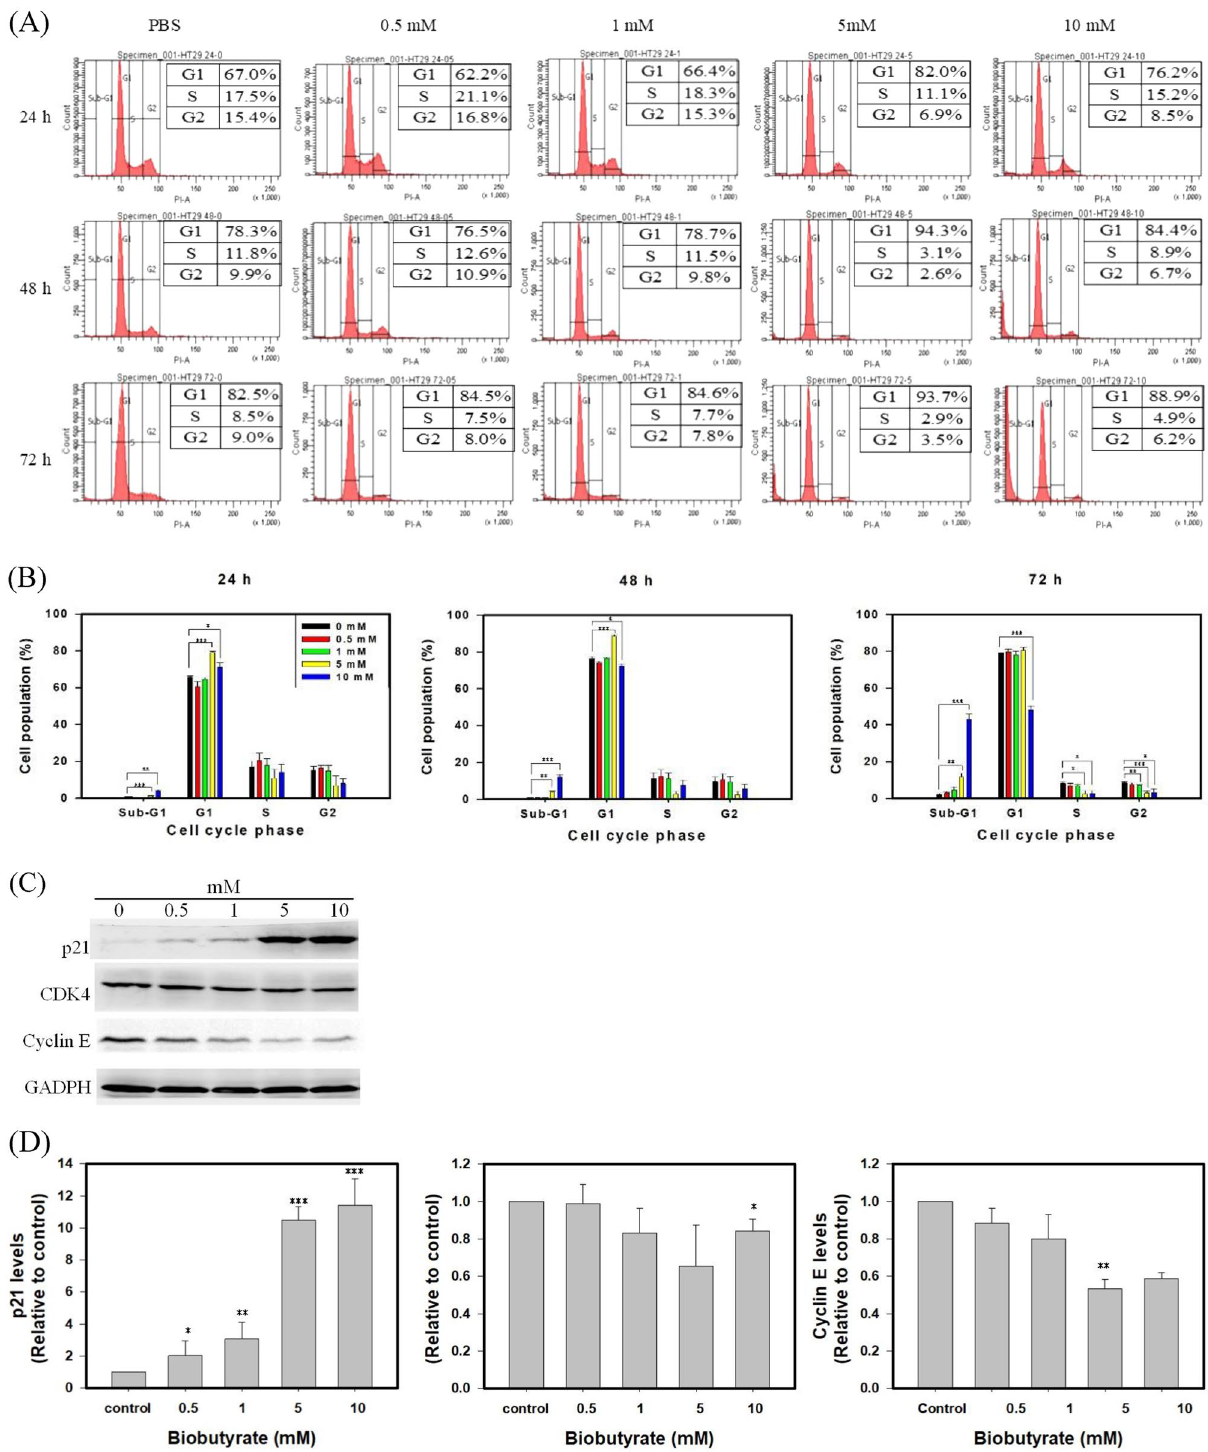
Figure 3. Cell cycle analysis. Cancer cells were treated with various concentrations of biobutyrate for 24, 48, and 72 h. The treatment of PBS was used as a control. ( A ) Flow cytometric analysis of biobutyrate-treated cells. After the treatment of biobutyrate, cells were analyzed by FACSCanto flow cytometer. ( B ) Quantification of cells at different stages of cell cycle. Data from three independent experiments were analyzed by the GraphPad Prism 7 software (* p < 0.05, ** p < 0.01 and *** p < 0.001 vs . control based on one-way ANOVA) and graphs were prepared using SigmaPlot 10.0 (Systat Software, San Jose, CA). ( C ) Immunoblotting analysis of the cell cycle regulatory proteins. HT29 cells were treated with various doses of biobutyrate for 24 h. ( D ) Quantification of the cell cycle regulatory proteins. Full-length blots are presented in Supplementary Fig. 3C. Data from three independent experiments were analyzed by the GraphPad Prism 7 software (* p < 0.05, ** p < 0.01 and *** p < 0.001 vs . control based on one-way ANOVA) and graphs were prepared using SigmaPlot 10.0 (Systat Software, San Jose,